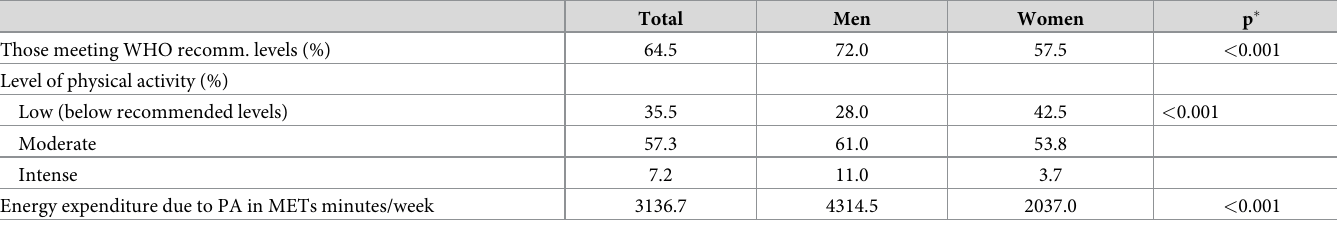
Table 4. Physical activity levels for those aged